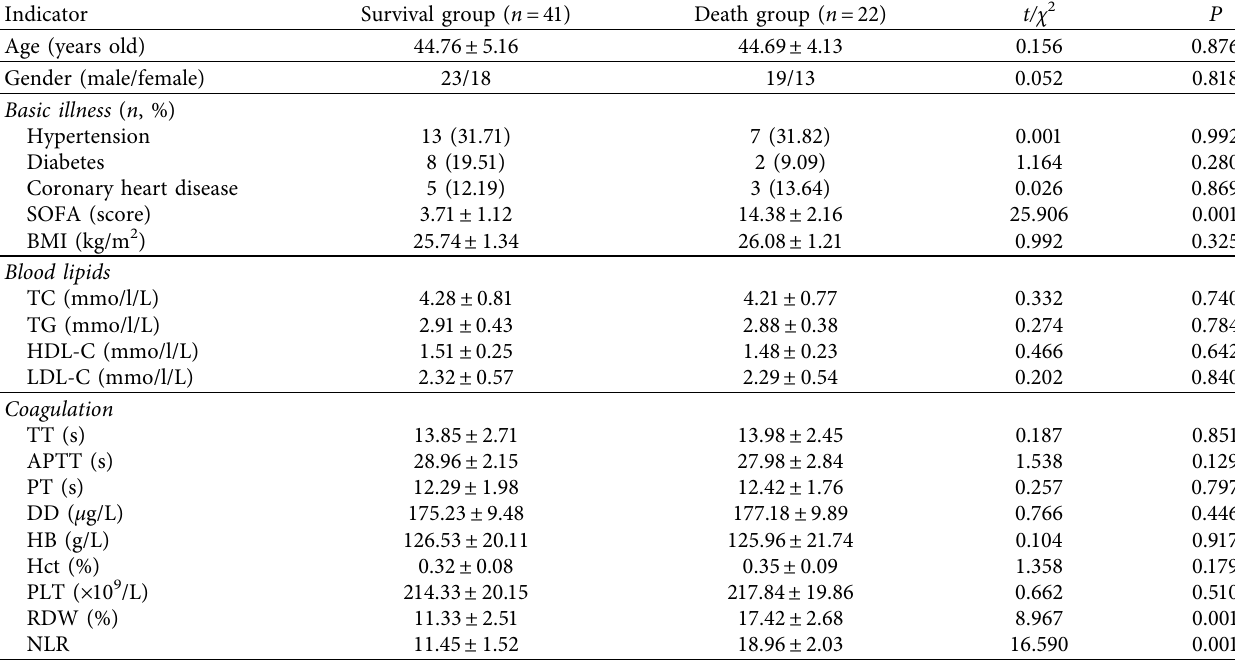
Table 1: Univariate analysis on those afecting the prognosis of emergency patients with sepsis. Indicator